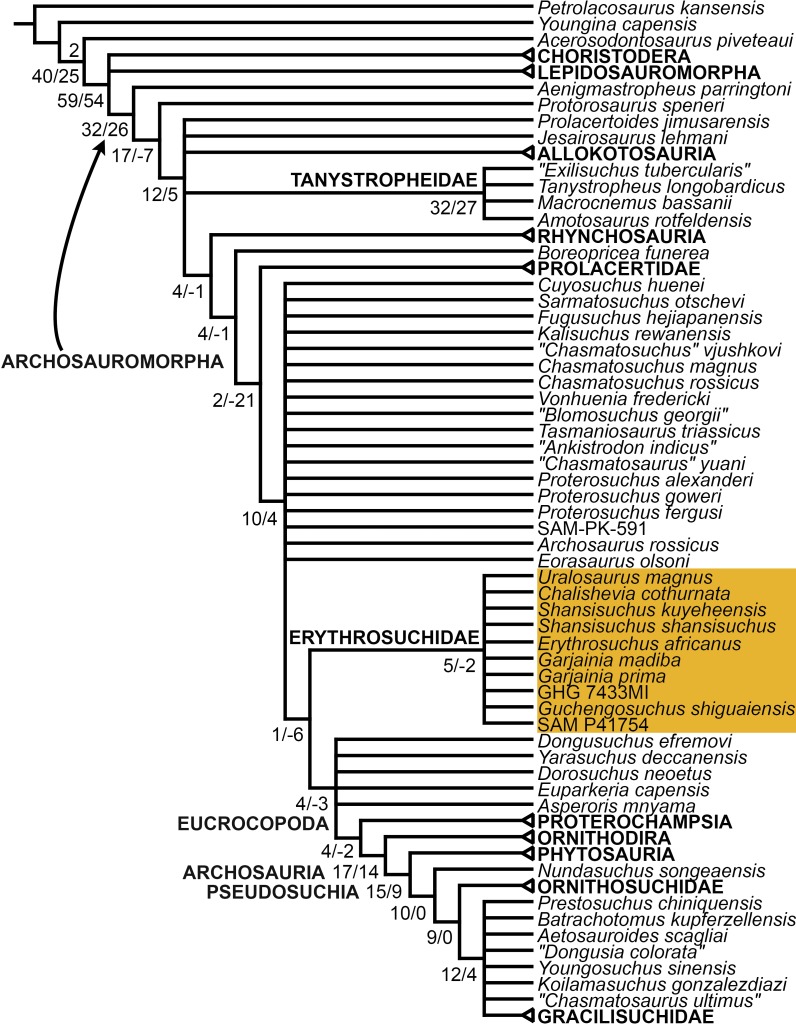
Strict consensus tree recovered from analyses 1 and 2.Numbers above internal branches are Bremer supports above 1 and numbers below internal branches are absolute (left) and GC (right) bootstrap frequencies in analysis 2. Erythrosuchids are highlighted in the brown box. Some clades have been condensed into suprageneric terminals to simplify the figure.